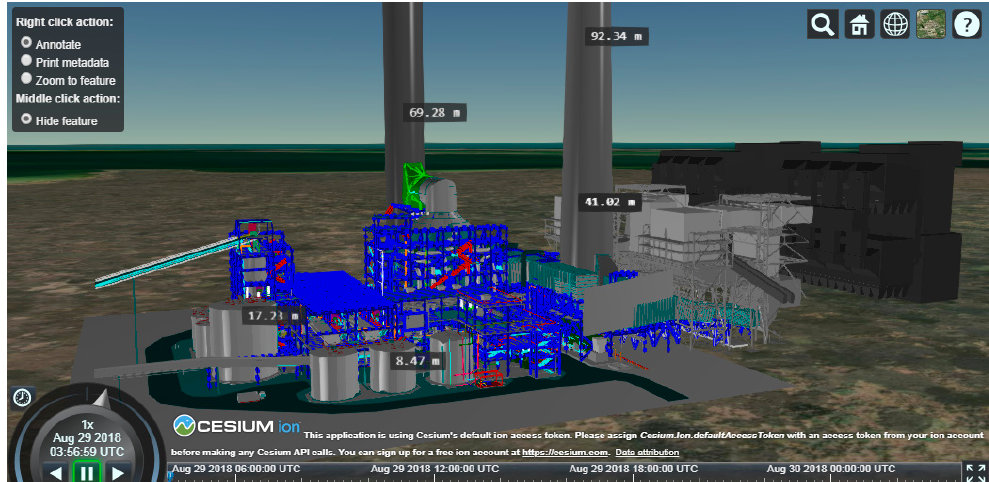
Figure 1. The first Building Information Model (BIM) example shown in Cesium Sandcastle (version 1.35). It is a power plant BIM converted into 3D Tiles by Bentley ® . Each component of the BIM is identifiable in Cesium.